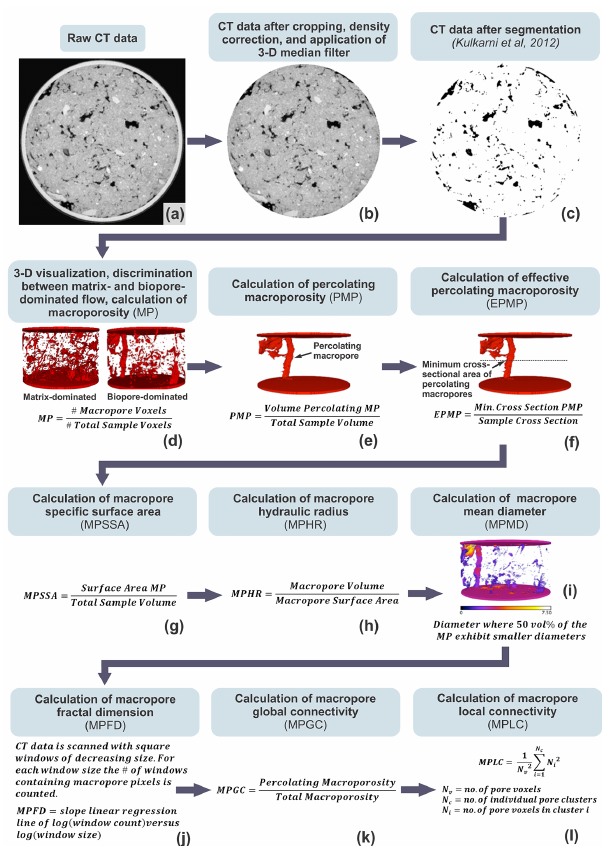
Figure 1. Flowchart illustrating all performed CT-data enhance- ment, segmentation, and analysis steps.